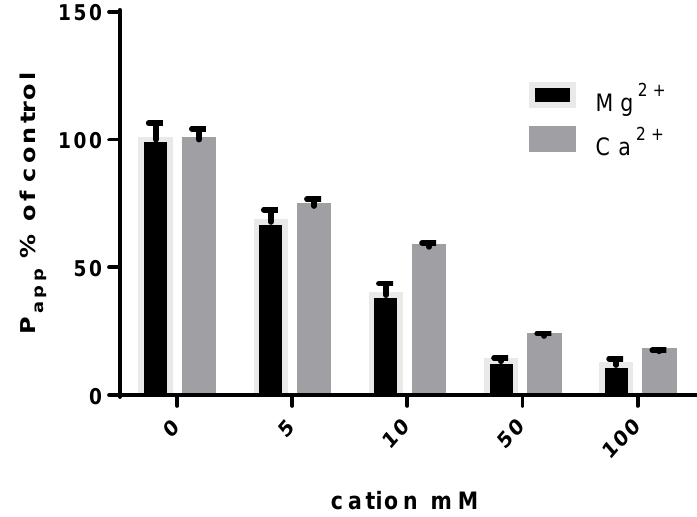
Figure 1. Influence of the Mg 2+ or Ca 2+ concentration on the ciprofloxacin (CIP) P app across the lung epithelial cell monolayer (Calu-3 cells) [23,31]. The apparent permeability was evaluated in the apical-to-basal direction. The same 50 µM concentration of CIP was used in each condition, in the presence of different concentrations of Ca 2+ or Mg 2+ .